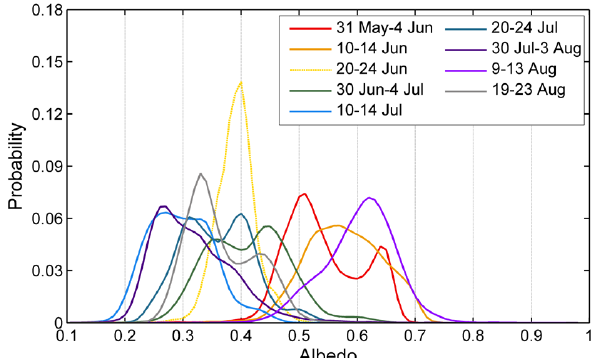
Figure 10. MODIS 100 × 100px spatial extent 5-day average albedo distributions for the 2012 melt season. Note that the 20–24 June 5-day average (yellow stippled line) is most likely erroneous due to an outlier in the MODIS data on 21–22 June 2012.